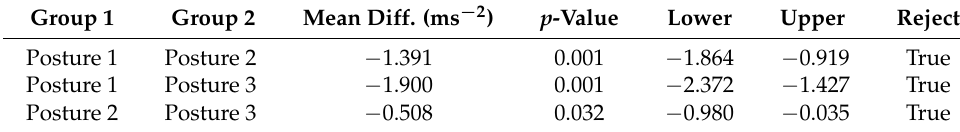
Table 4. Multiple comparison of tool vibration means (Tukey HSD, FWER = 0.05).